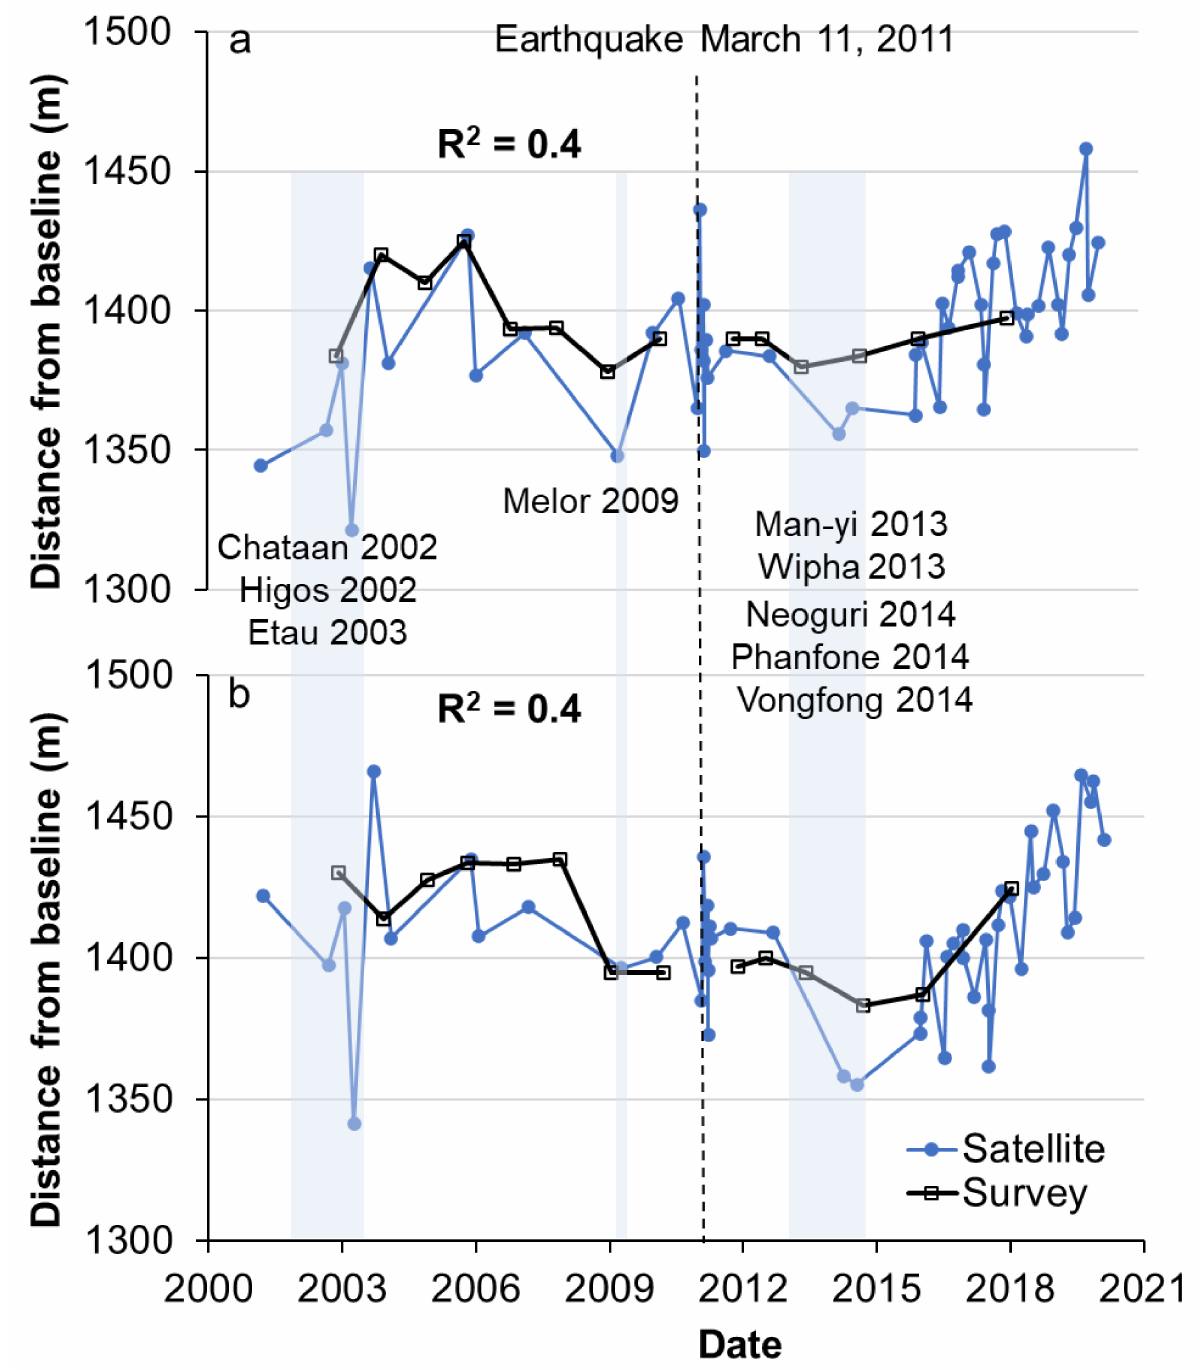
Figure 5. Variation of shoreline positions between observed and satellite-derived shorelines for locations at the north ( a ) and south ( b ) of Ariake. Locations of beach profile survey are depicted in the sub-panel of Figure 1a. The time-series of satellite-derived shoreline variability and trends exhibit reasonable agreement with the in-situ surveys (R 2 = 0.4). Names and years of typhoons travelled along the Honshu Island are